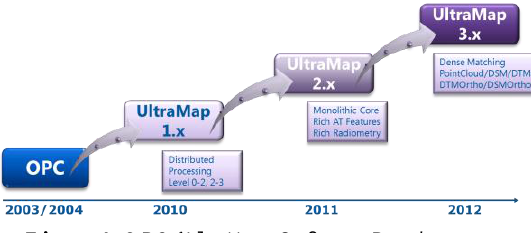
Figure 1. OPC/UltraMap Software